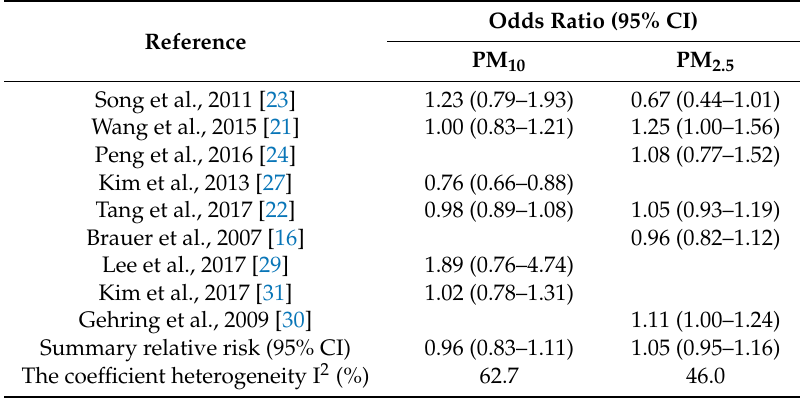
Table 3. Impact of PM on AD * for those young age.